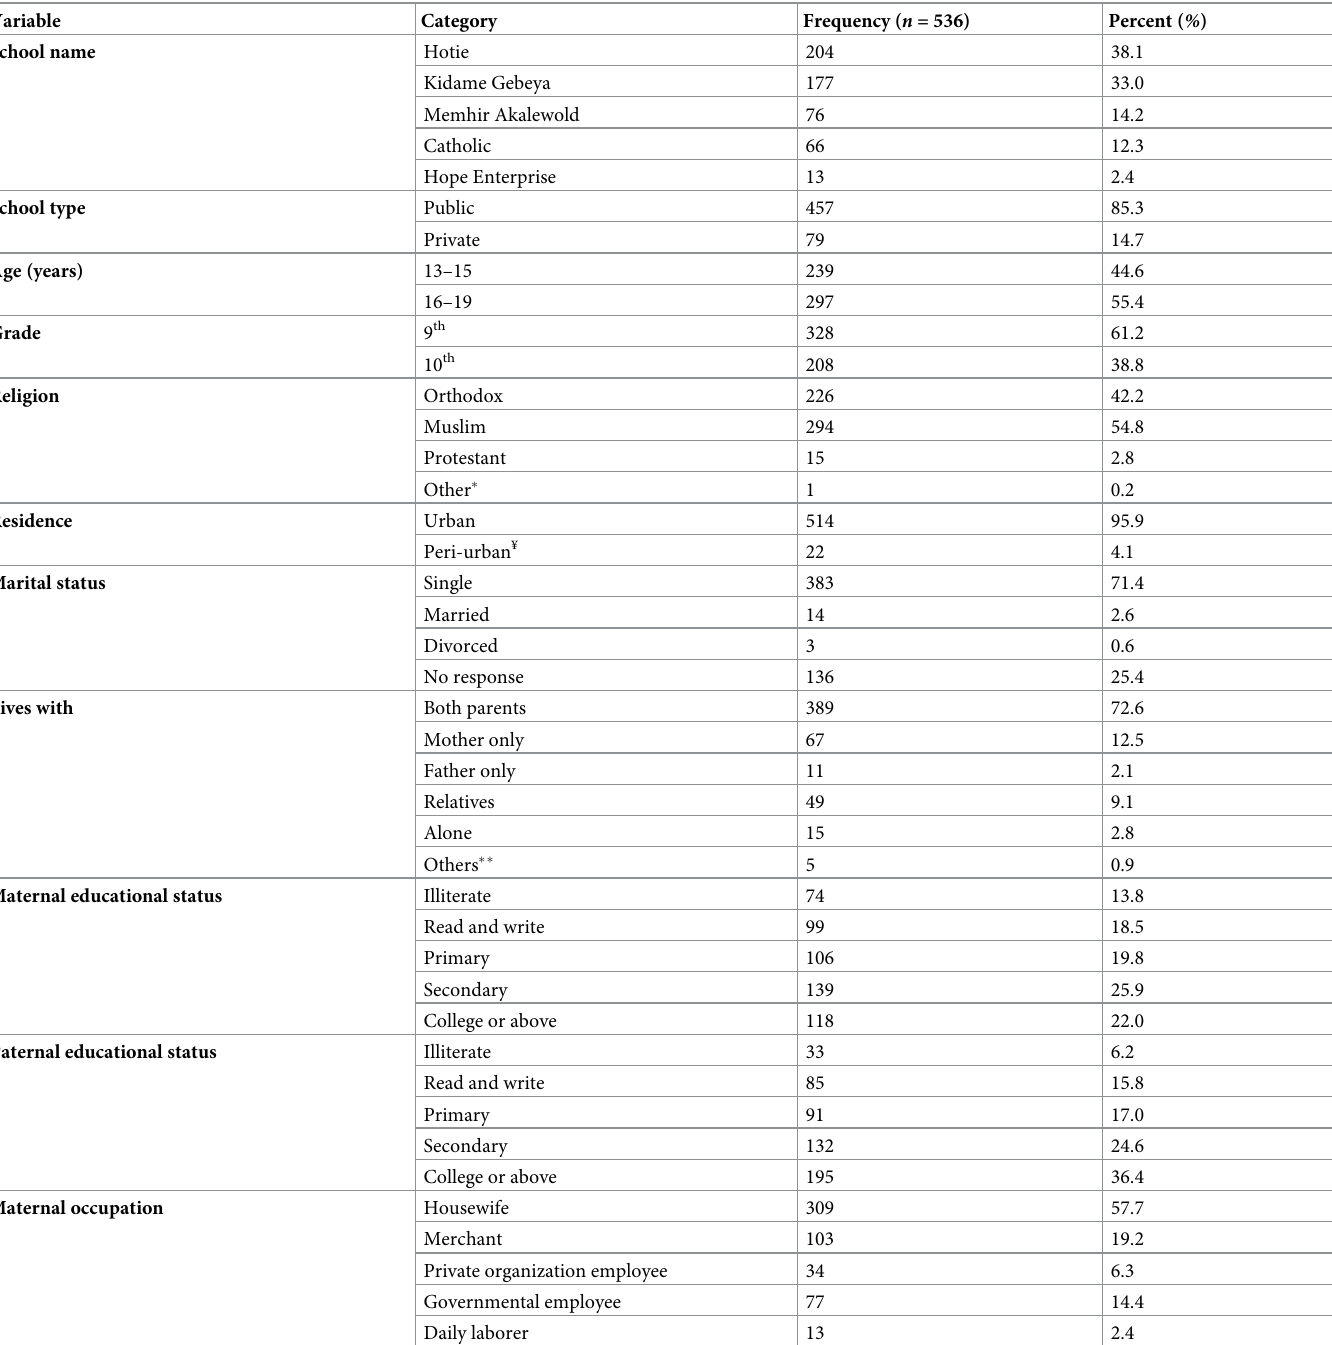
Table 1. Socio-demographic and economic characteristics of high school girls of Dessie City, Amhara Region, northeastern Ethiopia, 27 January to 6 March 2020.